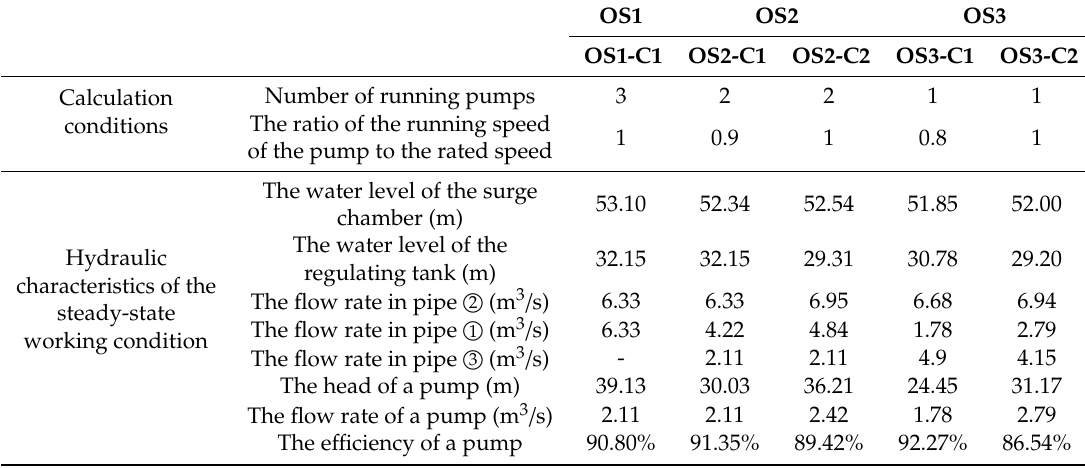
Table 3. The steady states of three operating scenarios for the Daxing Branch project.